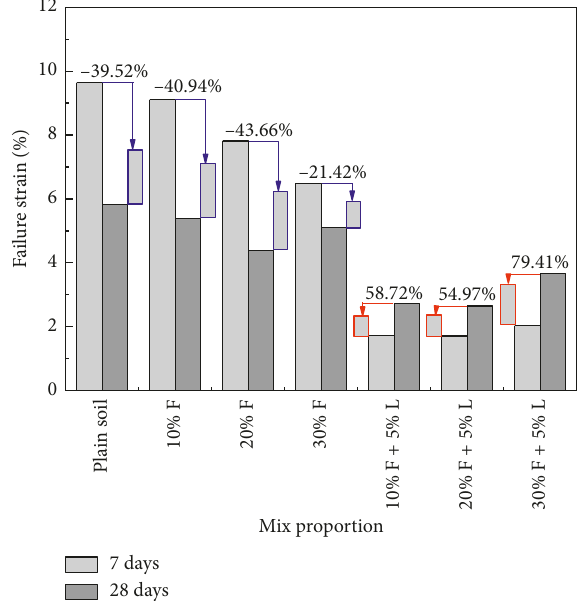
Figure 13: Variation laws of unconfined compressive failure with stabilizing time.